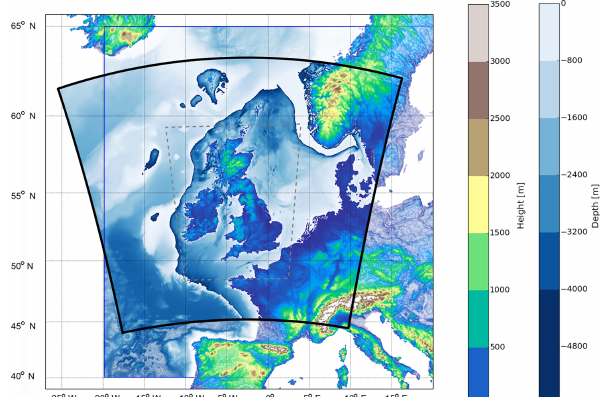
Figure 1. The UKC2 domain (black boundary) used to define UKA2 atmosphere, UKO2 ocean and UKW2 wave components. The model orography and bathymetry are also shown. The blue out- line shows the extent of the current operational AMM7 ocean do- main (see Sect. 3.3). The grey dashed area shows the approximate extent of the regular 1 . 5 × 1 . 5km inner region of the UKA2